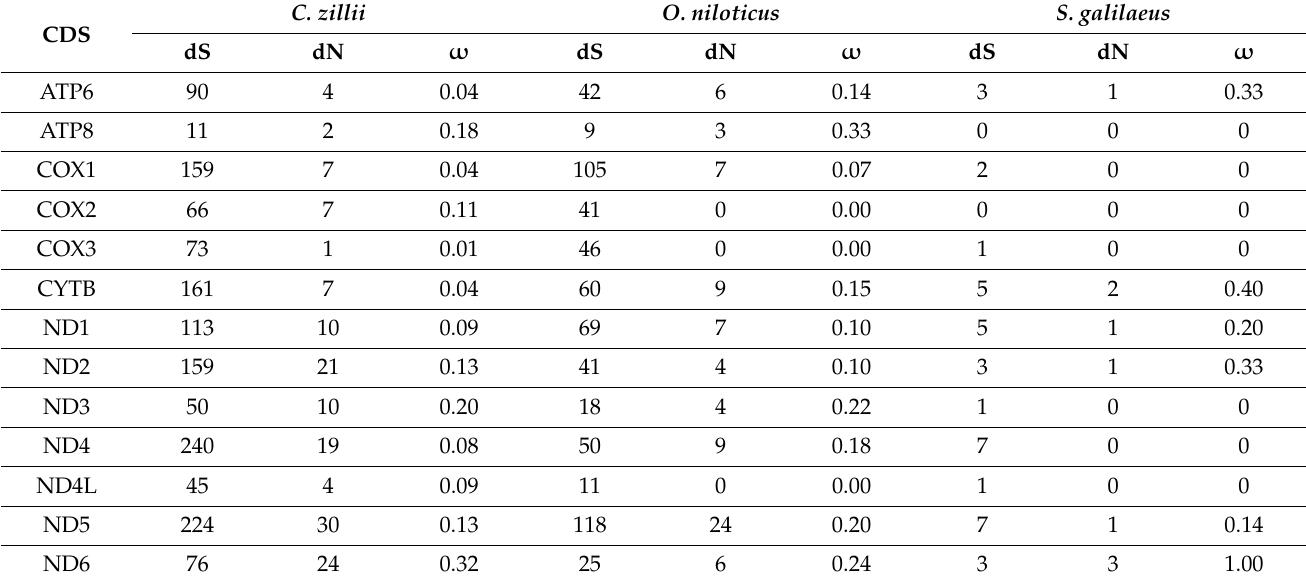
Table 2. The substitution rate of 13 protein-coding genes among the Nile tilapiine mitogenomes, the number of nonsynonymous substitutions (dS), the number of synonymous substitutions (dN), and the ratio